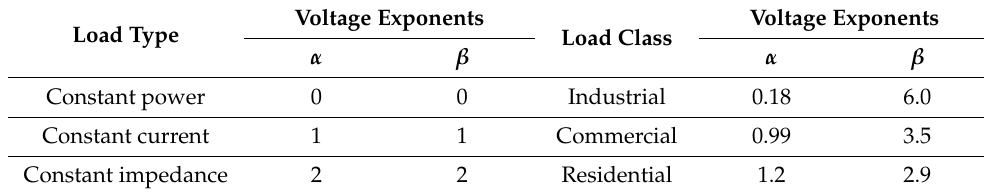
Table 2. Load type and load class with their voltage exponents.